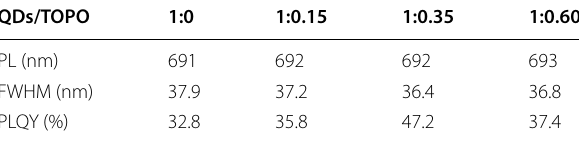
Table 1 Optical properties of CsPbI composite